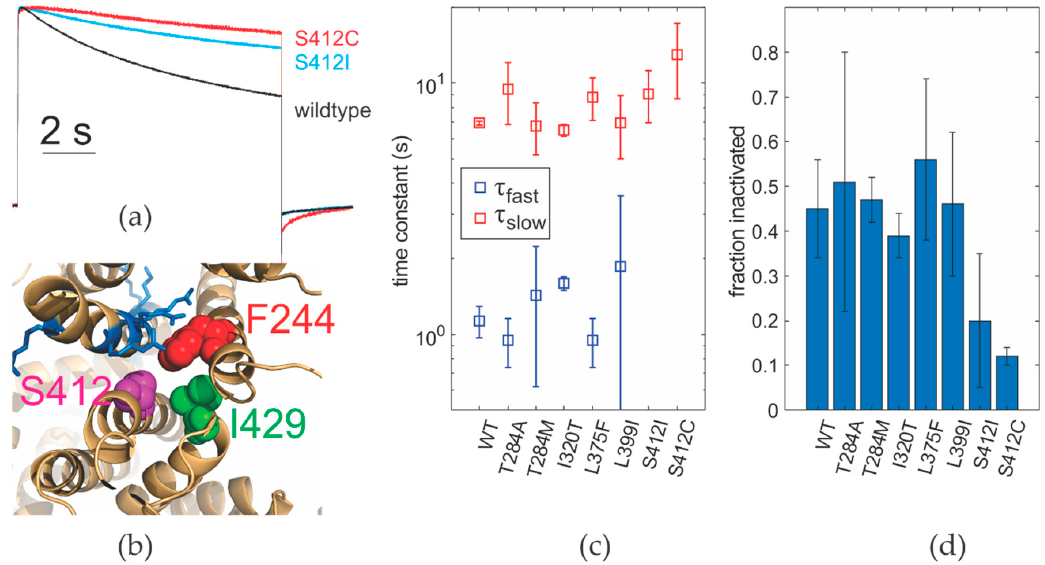
Figure 3. ( a ) Inactivation time courses of wildtype, S412I and S412C determined at 0, + 30 and + 20 mV, respectively. Current traces were normalized to maximal current. ( b ) Non-canonical coupling. S412C is positioned neighboring F244C and I429. Blue denotes the gating charges in the S4. ( c ) Time constants of inactivation for di ff erent EA1 mutants (WT: 0 mV, T284A: 30 mV, T284M: 0 mV, I320T: 60 mV, L375F: 60 mV, L399I: 30 mV, S412I: 60 mV, S412C: 50 mV; n = 3–7). ( d ) Fraction of channels inactivated after 8 s (membrane potentials as in ( c ); n = 3–7). Table 3. Inactivation time constants of the EA1 mutants.